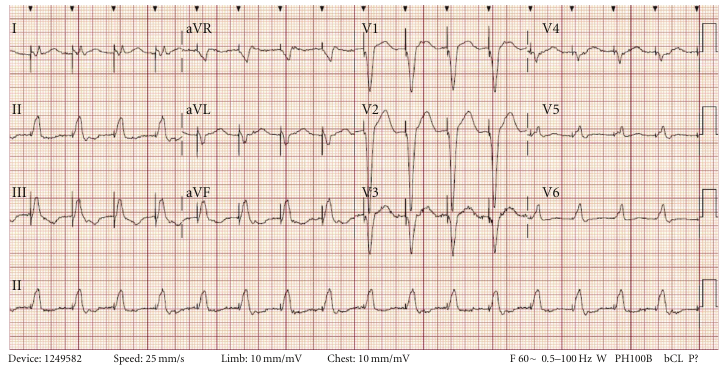
Figure 5: Intravenous temporary pace maker was inserted for sinus bradycardia with long QTc. To prevent TdP, pacing rate was set at 100beats per minute.